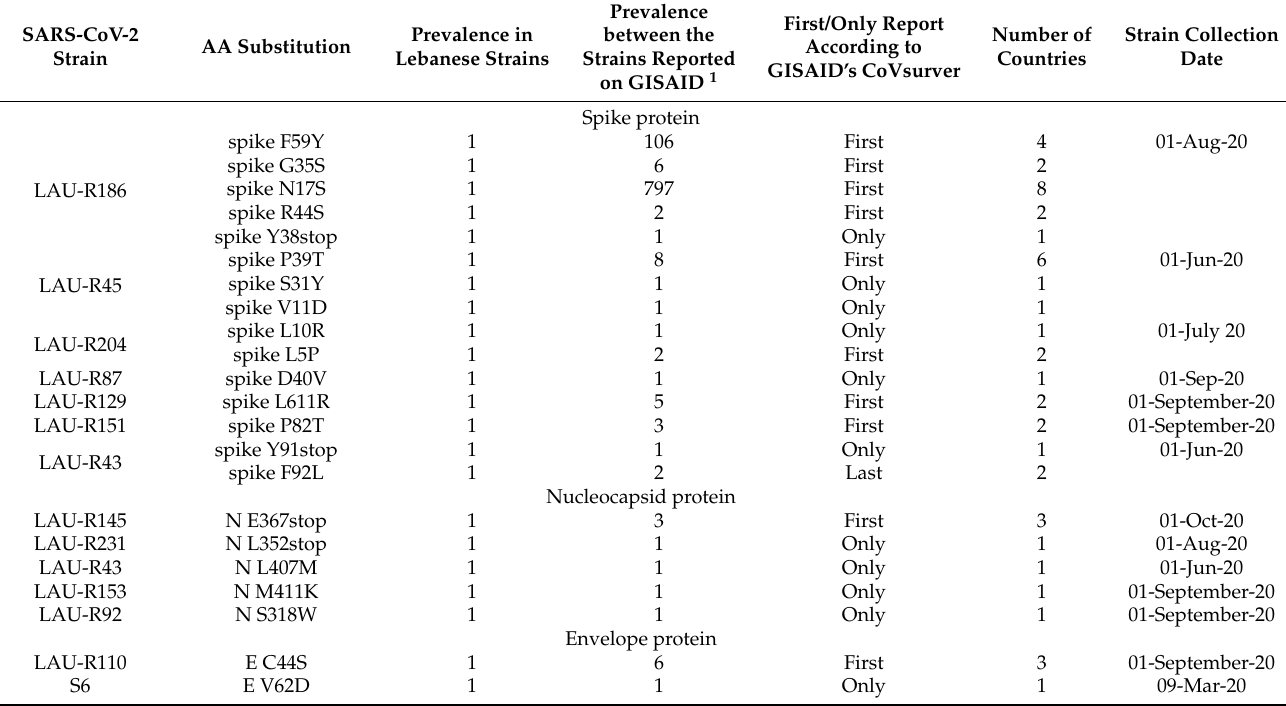
Table 3. List of uncommon AA substitutions detected in the structural proteins S, N, and E of the analyzed Lebanese SARS-CoV-2